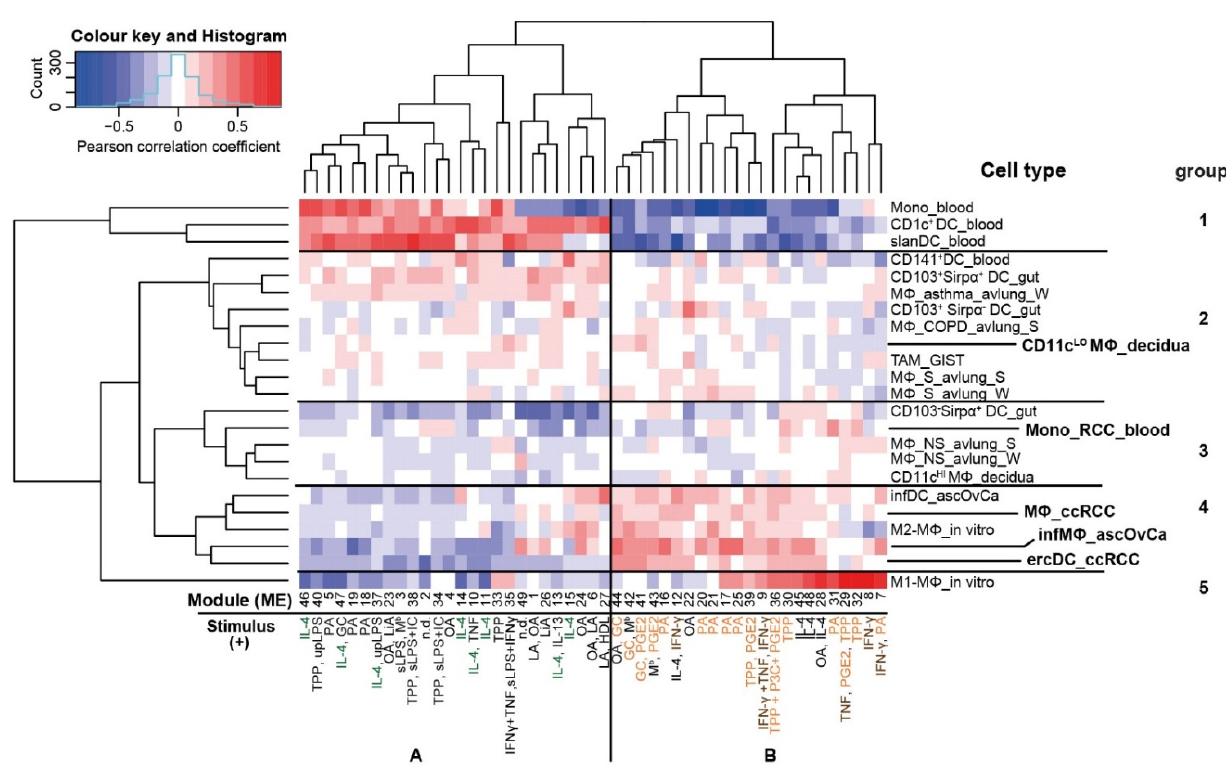
Figure 7. Polarization profile of ccRCC_ercDC reveals distinct tissue imprints. Heatmap of Pearson correlation coefficients calculated between module eigengenes (ME) and myeloid cell types. Cell types were clustered based on correlations with stimuli-associated eigengene modules. Depicted are the numbered modules with up to two significantly positively correlated stimuli for each module. Stimuli dominating in module group ( A ) are highlighted green, in module group ( B ) in orange and brown. Stimuli negatively correlating with the modules as well as the correlation rules for stimuli and modules are listed in Table S13.